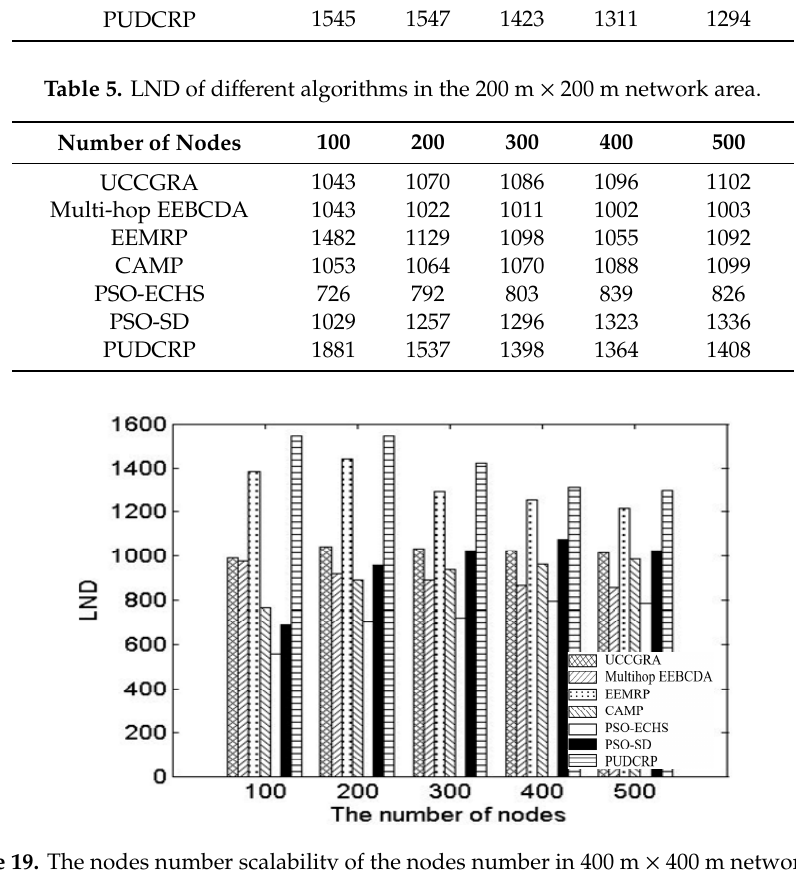
Table 5. LND of different algorithms in the 200 m × 200 m network area.